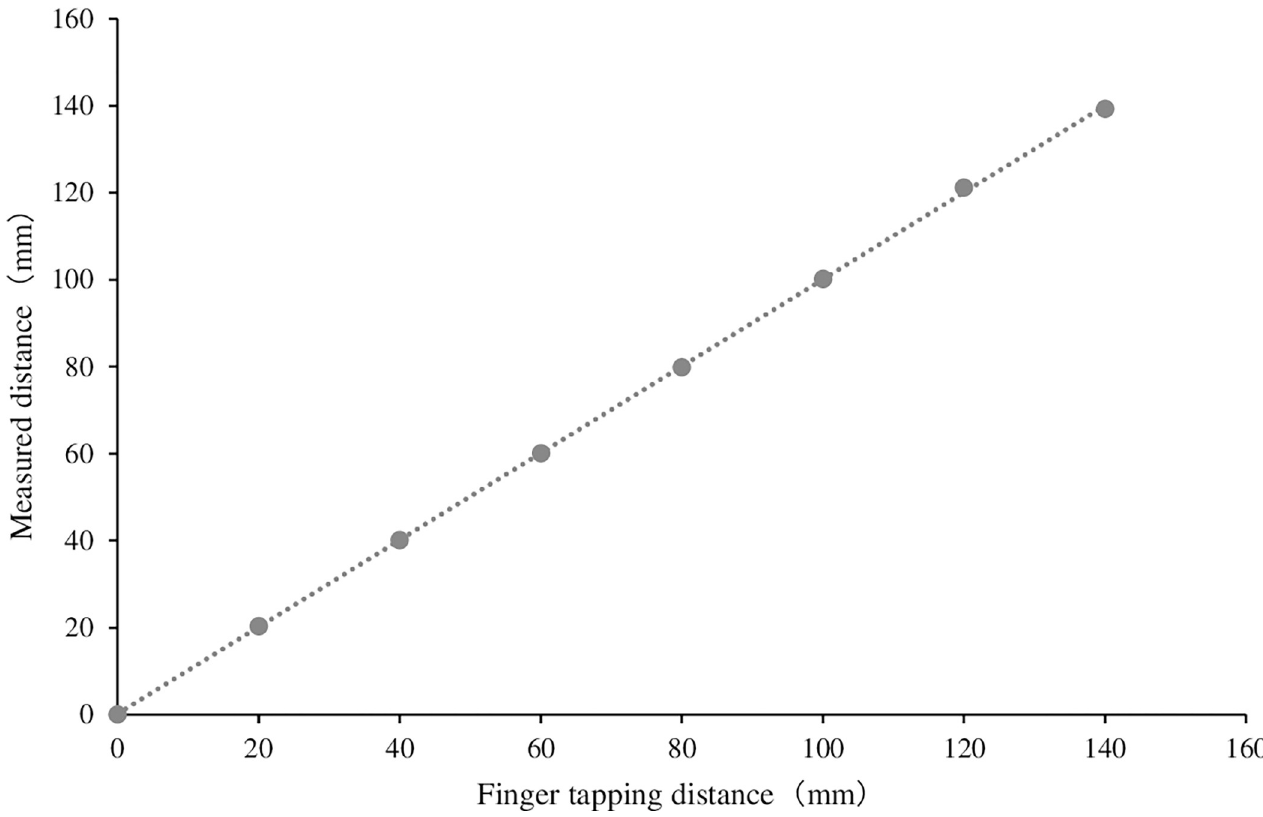
Fig 3. Output characteristics of the measuring equipment. Fig 3 shows the relationship between the finger-tapping distance (mm) and the measured distance (mm) of the device. The slope of the regression line and the R 2 value were 0.9991 and 0.9999, respectively.